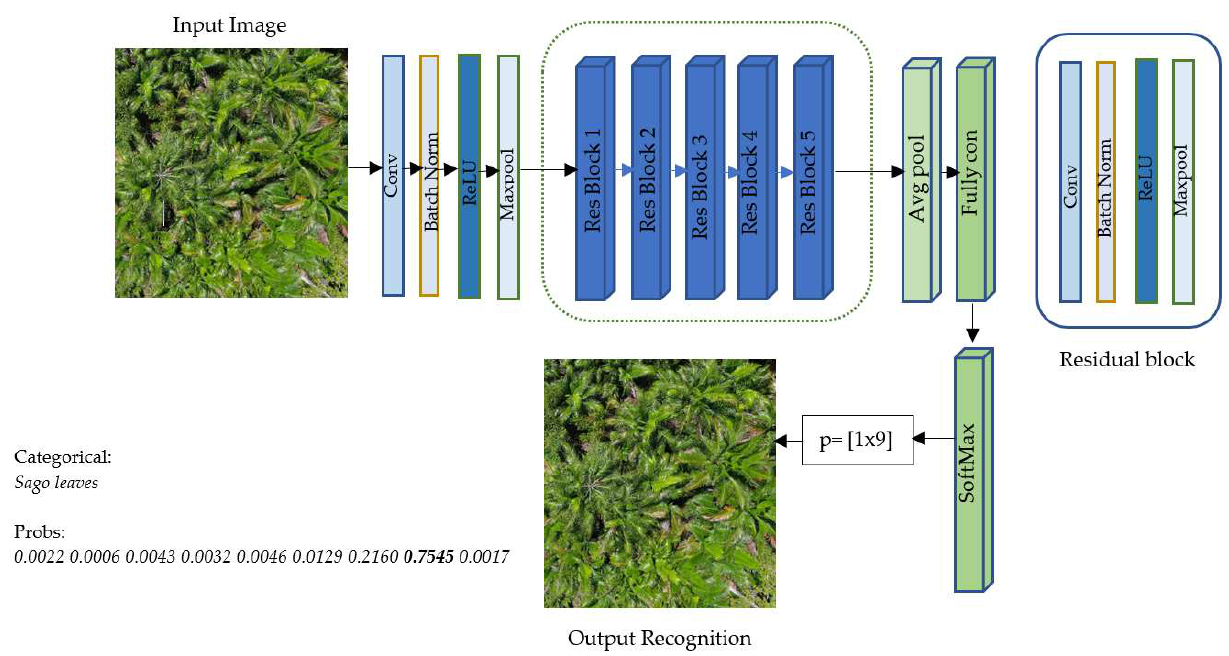
Figure A3. Sample dataset: testing data.